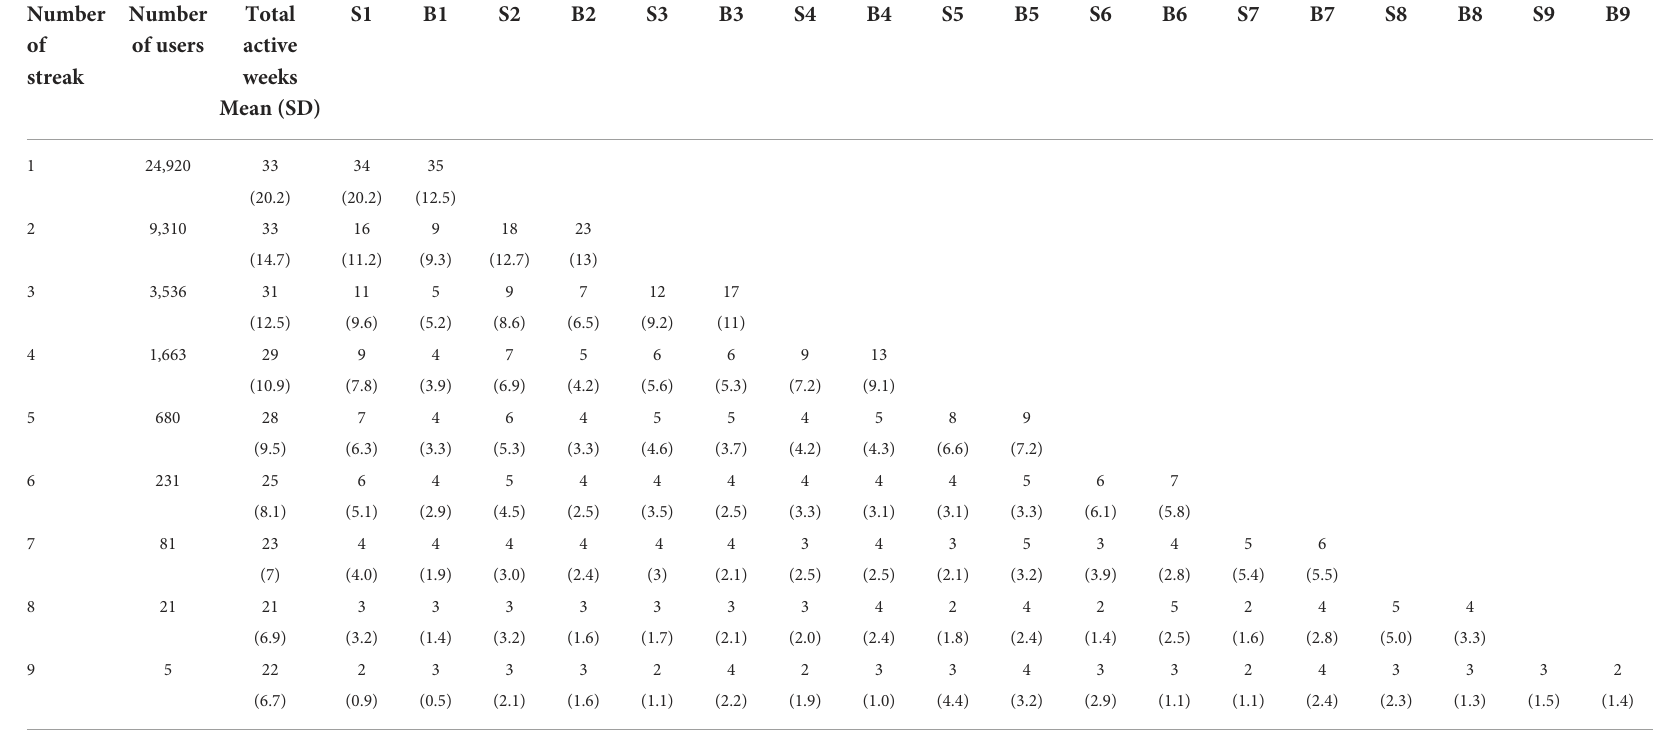
TABLE 1 Frequency and length of streaks and